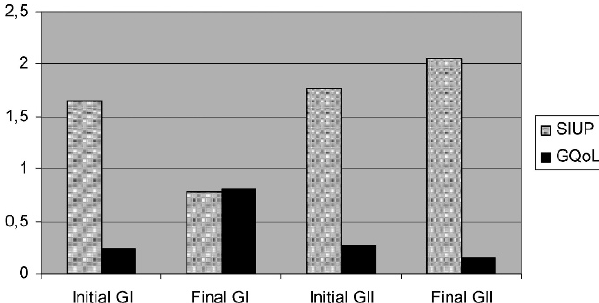
Figure 4 - The means of the final evaluations of the Qualiveen domains (Specific Impact of Urinary Problems on Quality of Life (SIUP) and General Quality of Life (GQoL)) before and after the intervention in the treatment (GI) and sham (GII) groups. Mean: 1.65 initial and 0.78 final in GI and 1.77 initial and 2.05 final in GII in the SIUP domain ( p =0.0001). Mean: 0.23 initial and 0.81 final in GI and 0.27 initial and 0.15 final in GII in GQoL ( p